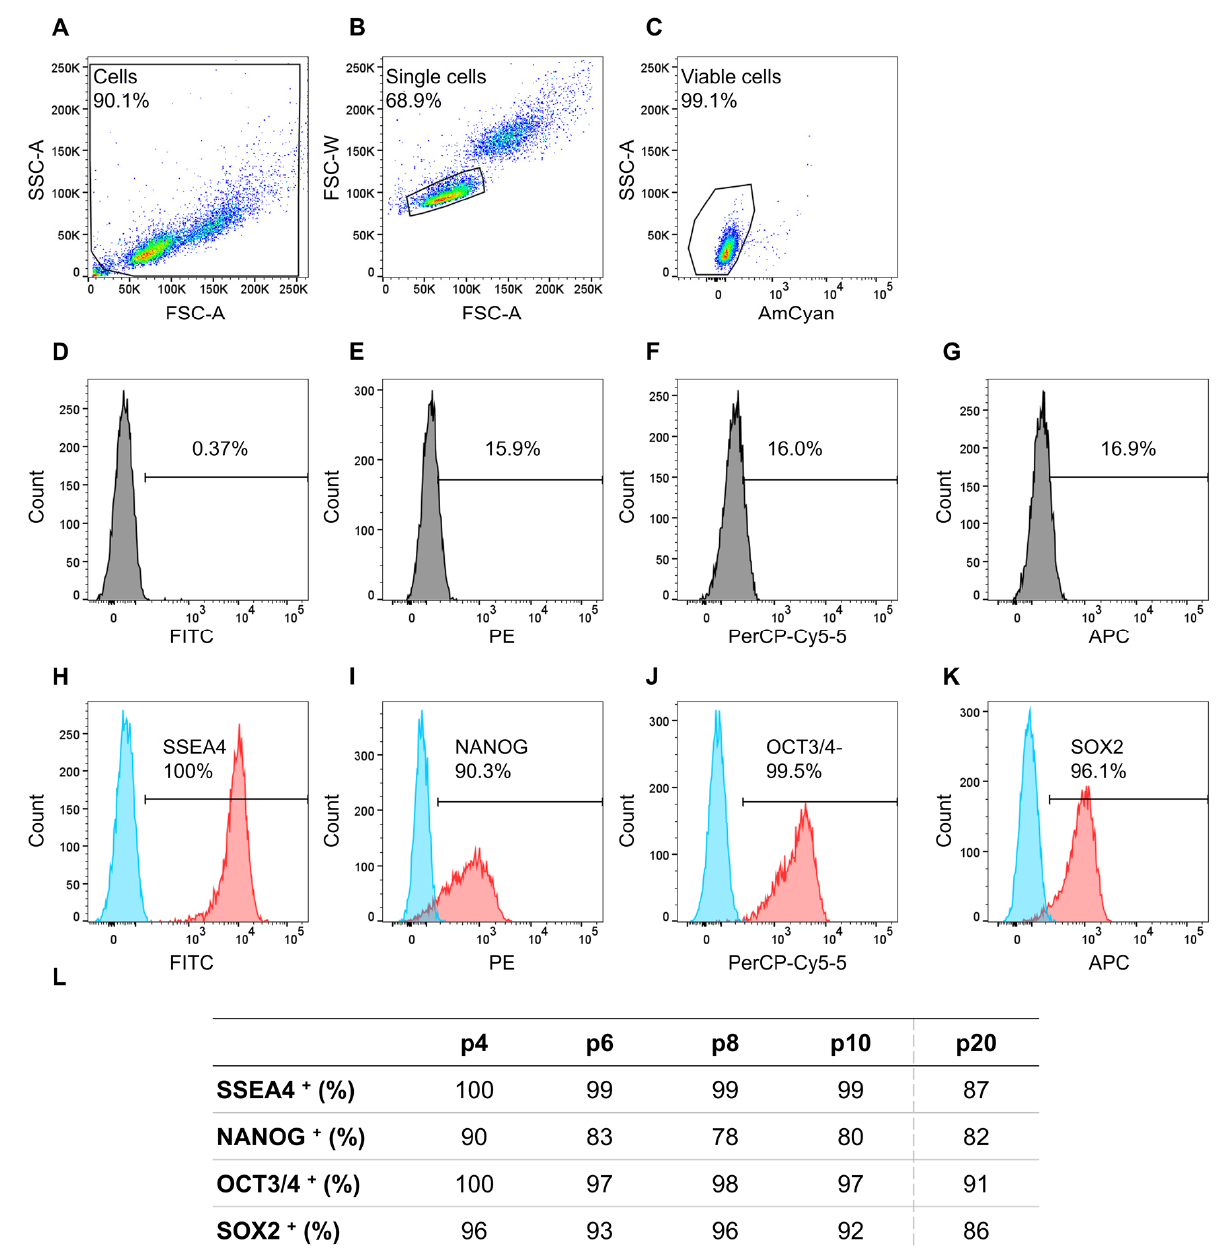
Figure 2. Flow cytometry analyses of cell line iPS11 analyzing stem cell markers NANOG-PE, OCT3/4-PerCP-Cy5.5, SOX2-Alexa Fluor 647, and SSEA-4-FITC, plus fixable viability stain 510 (FVS510) as a live/dead discriminator. The human induced pluripotent stem cell (hiPSC) line iPS11 was cultured in FTDA on Laminin521 (LN521)-coated 6-well plates in a single-cell-based culture and analyzed every other passage (p) from p4 to p10 and p20. The acquisition was performed using a BD FACSCanto™ II system operated with the BD FACSDiva™ software; further analysis was conducted with FlowJo. ( A ): Gating strategy for the relevant cell population. ( B ): Gating strategy to ensure analyses of single cells. ( C ): Gating strategy to discriminate between live and dead cells. ( D – G ): Isotype controls for the respective antibodies. ( H – K ): The threshold/gate was set to a maximum of 0.49% positive cells in the unstained control, every signal above was counted as a positive signal. Exemplary flow cytometry results of hiPSCs in p4a for the markers NANOG-PE, OCT3/4-PerCP-Cy5.5, SOX2-Alexa Fluor 647, and SSEA-4-FITC, blue peak: unstained cells, red peak: positively stained cells. ( L ): Percentages of positively stained cells (indicated by +) of the flow cytometry analyses from p4 to p10 and p20 for the indicated